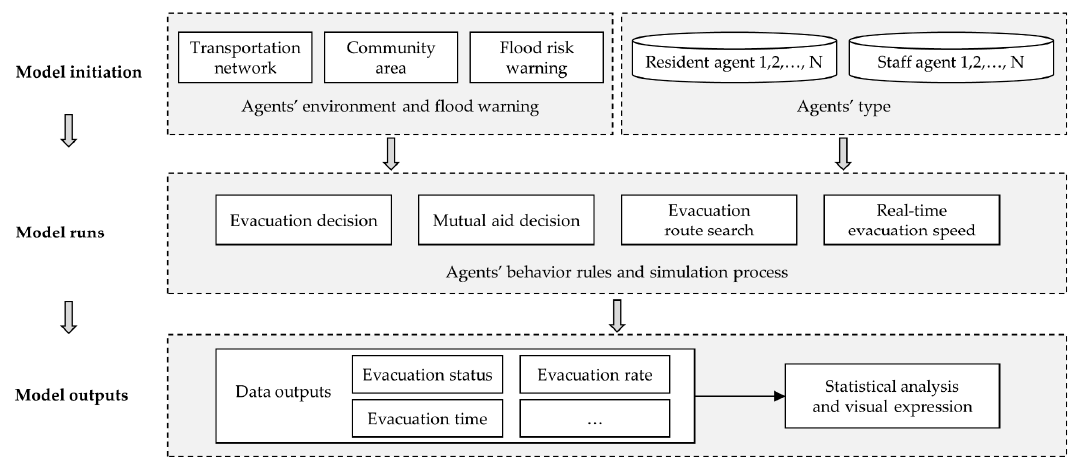
Figure 1. Framework of the agent-based model for flood evacuation process simulation. Each time step, the flood risk perception of agents was updated and agents took action.